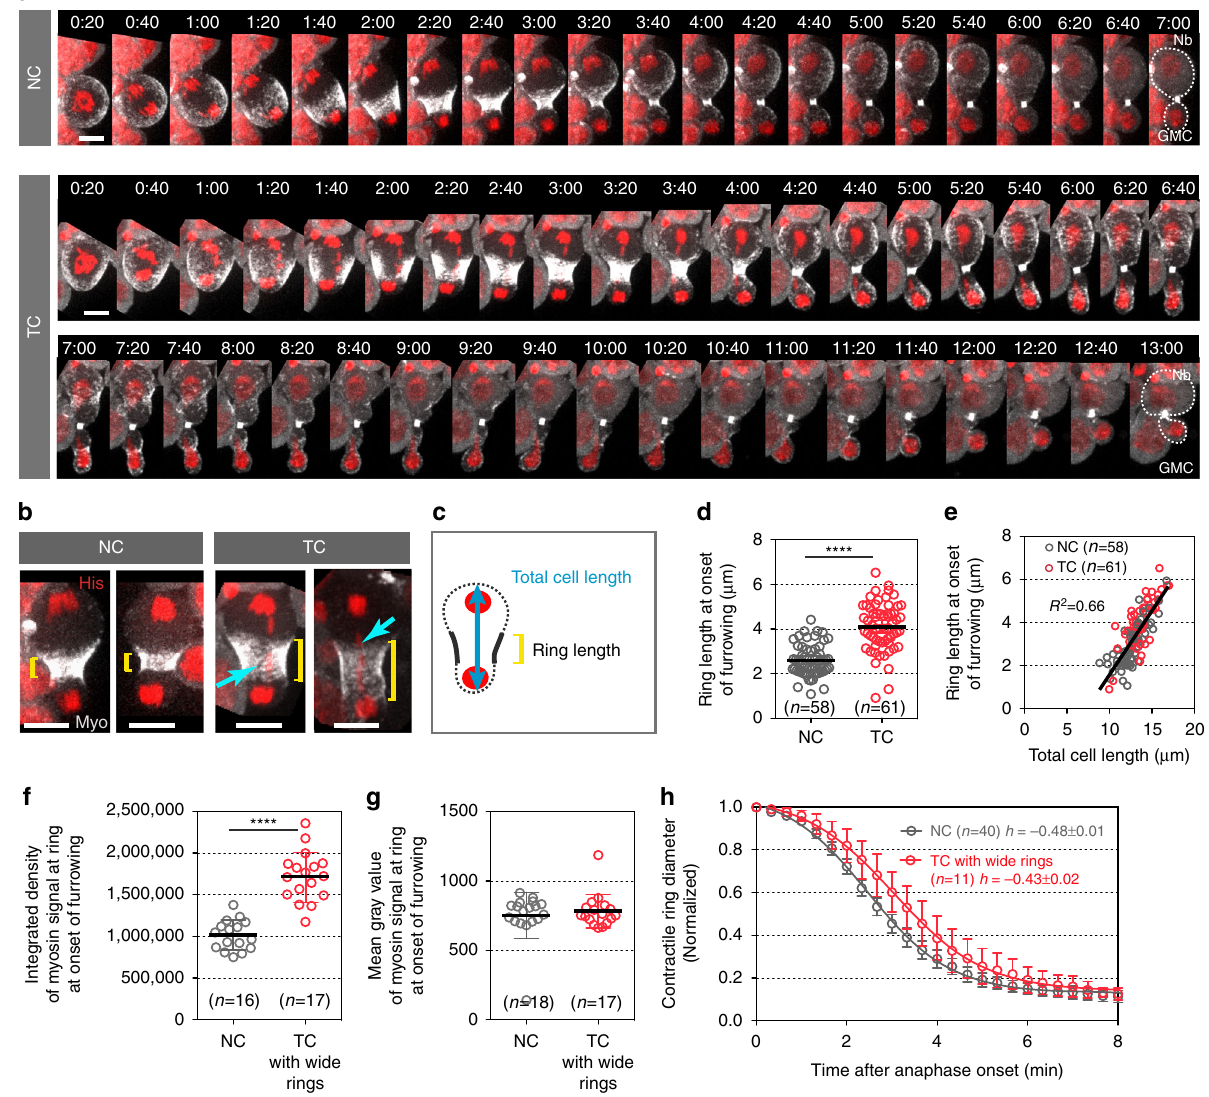
Figure 1 The presence of trailing chromatids at the midzone triggers the assembly of a wide contractile ring. a Myosin dynamics in cells carrying normal- length chromatid arms (NC) and cells with trailing chromatid arms (TC). Time-lapse images of live Drosophila third instar larvae neuroblasts expressing a chromatin marker, H2Az::mRFP (His, red ) and a non-muscle myosin II marker, Sqh::GFP (Myo, gray ). Neuroblasts divide asymmetrically to give rise to two daughter cells of different sizes, a large neuroblast ( Nb ) and a small ganglion mother cell ( GMC ) ( white dashed lines ). See Supplementary Movie 1. Time = min:s. Scale bars = 5 µ m. b Images of two different cells with NC or TC expressing H2Az::mRFP (His, red ) and Sqh::GFP (Myo, gray ) at the onset of furrowing. The length of the contractile ring is indicated with yellow brackets . The cyan arrows point to TC. Scale bars = 5 µ m. c Scheme of a cell at onset of furrowing to illustrate the measurements of ring length and total cell length. d Scatter dot plot showing the distribution of ring length at the onset of furrowing. e Graph showing the linear correlation ( R 2 = 0.66) of the total cell length with the ring length at the onset of furrowing. f , g Scatter dot plots showing the integrated density ( f ) and mean intensity ( g ) of myosin signal at the contractile ring of cells with NC and cells with TC speci fi cally exhibiting wide rings at the onset of furrowing. h Graph showing the diameter of the contractile ring over time for cells with NC or TC with wide rings from AO. Data points were fi t to a sigmoid curve. The Hillslope ( h ) is used to compare the rate of furrow invagination. All cells are oriented so that the daughter Nb is apical and the daughter GMC is basal. Time 0:00 corresponds to anaphase onset (AO, initiation of sister chromatids separation). n = number of cells. The mean ± 95% CI is presented for all graphs and scatter dot plots. A Mann-Whitney test was used to calculate P values (**** corresponds to P <